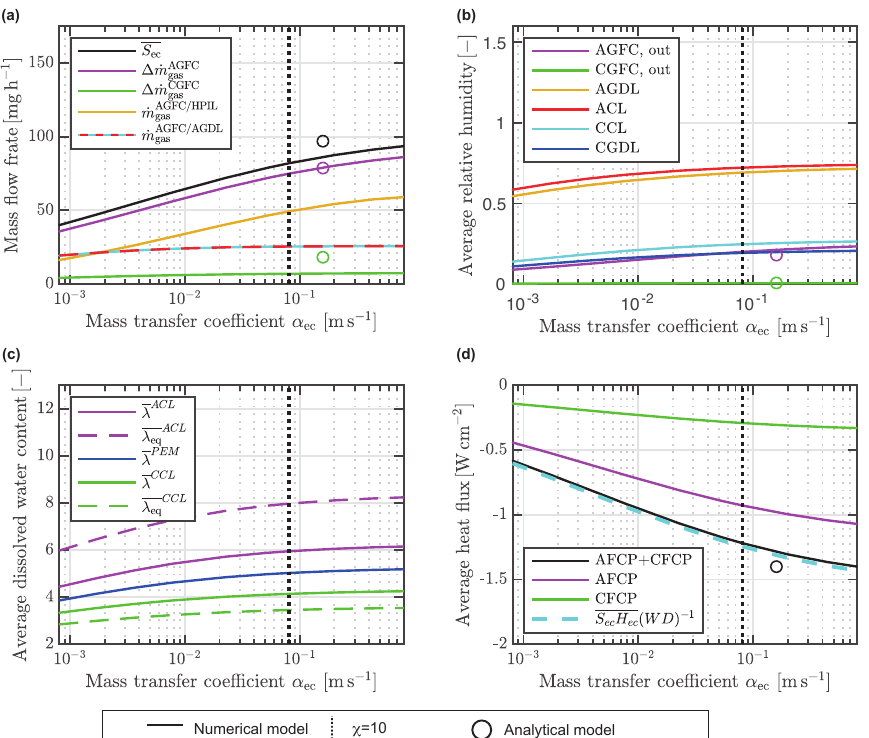
Figure 3. Key output parameters as defined in Table A5 as a function of the mass transfer coefficient for evaporation: ( a ) integrated evaporation rate and mass flux leaving the cell via the AGFC/CGFC and entering the AGFC via the interfaces with the HPIL and AGDL, respectively; ( b ) average relative humidity in different domains and at the GFC outlets; ( c ) average dissolved water content and equilibrium hydration number; and ( d ) average heat flux across the anode and cathode FCP ends. Base case results for χ = 10 are highlighted. For comparison we show the results from the analytical model of Cochet et al. [10] (Appendix A) using the same base case parameterization as in the numerical